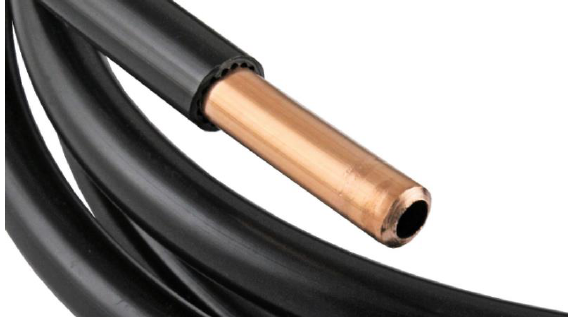
Fig. 5. Copper pipe for liquid gas fuel [11]